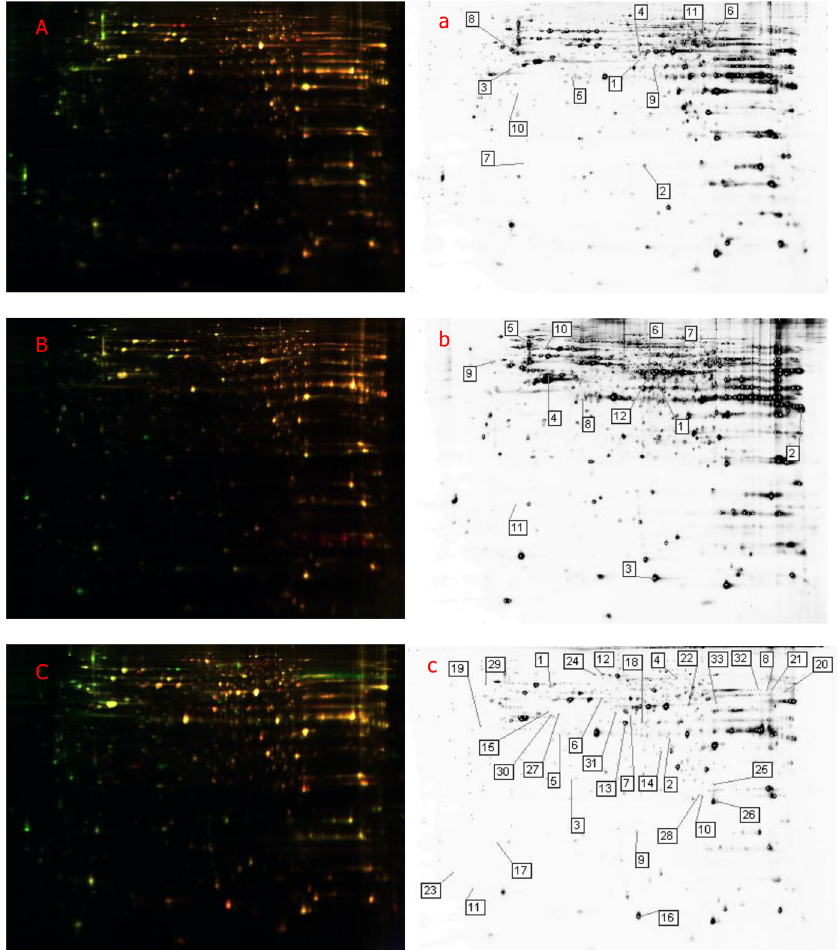
Fig 1. 2D- DIGE images and differentially expressed proteins of H7N9- and H1N1pdm09-infected A549 cells. The 2D- DIGE images of A549 cells infected with H7N9 and H1N1pdm09 influenza virus at 24 (A), 48 (B) and 72 (C) hpi. 2D- DIGE analysis of the differentially expressed spots between H7N9- and H1N1pdm09-infected A549 cells at 24 (a), 48 (b) and 72(c) hpi.